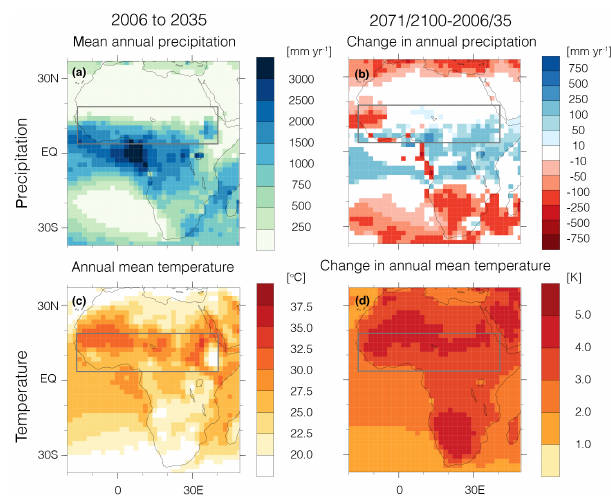
Figure 3. (a, c) Ensemble mean annual precipitation sum (mm) and temperature ( ◦ C) for the first 30years of RCP8.5 scenario (2006 to 2035) (left column) and (b, d) the difference (right column) with re- spect to the last 30years of this century (2071 to 2100 minus 2006 to 2035). Only significant differences ( t test, 95% significance level) are show. Both small changes in precipitation and non-significant changes are in white (b)